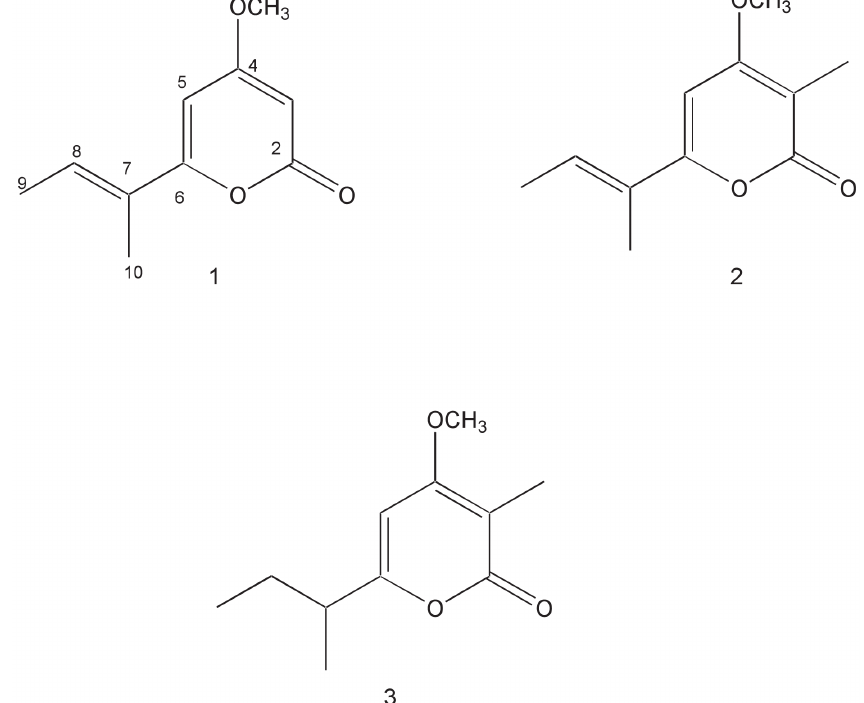
Figure 1. Structures of pestalopyrone, nectriapyrone and its dihydroderivative ( 1 , 2 and 3,